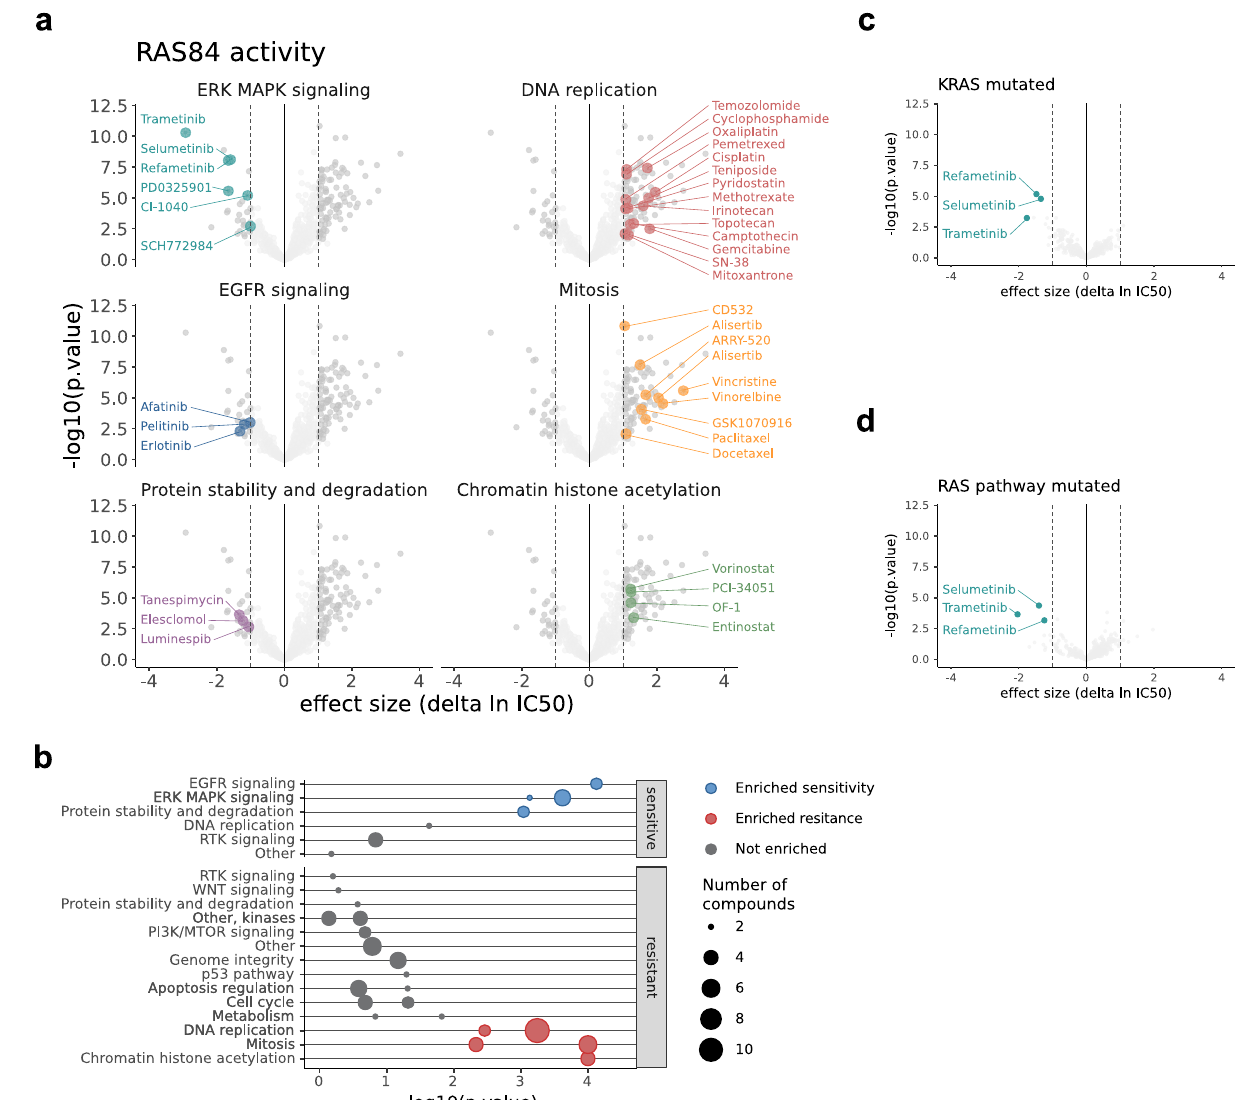
Fig. 2 | In vitro anticancer drug screen. a Volcano plots showing differences in IC50 values between RAS high and low CCLE cell lines. Drugs with enriched target annotations in the signi fi cant sensitive and resistant groups are highlighted (hypergeometric test) Drugs with an absolute log2 fold change >1 and fdr < 0.05 (linearmodelwithBenjamini-Hochbergcorrection)areshownindarkgrey.Results from both GDSC1 & 2 are shown. b Drug target annotation enrichment in sensitive and resistant drugs from GDSC1 & 2 (fdr<0.05) in the RAS high CCLE cell lines, determined by hypergeometric test with Benjamini – Hochberg correction. Target